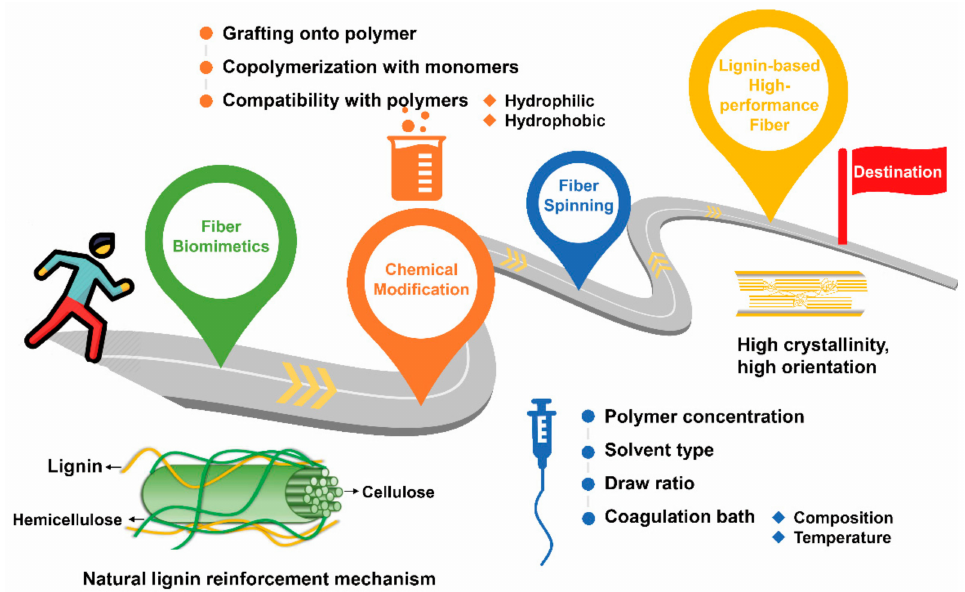
Figure 10. Roadmap of future research directions of lignin-based high-performance